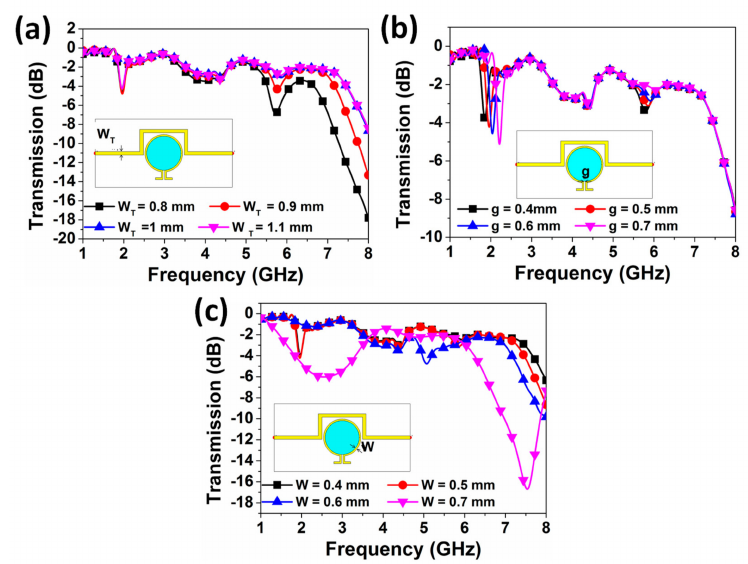
Figure 5. E ff ect of the variation of ( a ) width of the transmission line W T , ( b ) gap of the omega-shaped resonator g, and ( c ) width of the omega-shaped resonator W on the resonance frequency.